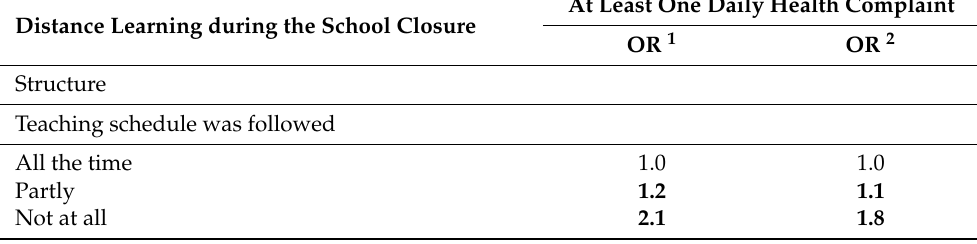
Table 4. Effects of distance learning variables on daily health complaints. Results of logistic regression modelling. Odds ratios (OR) of bivariate and multivariate models. Significant variables in